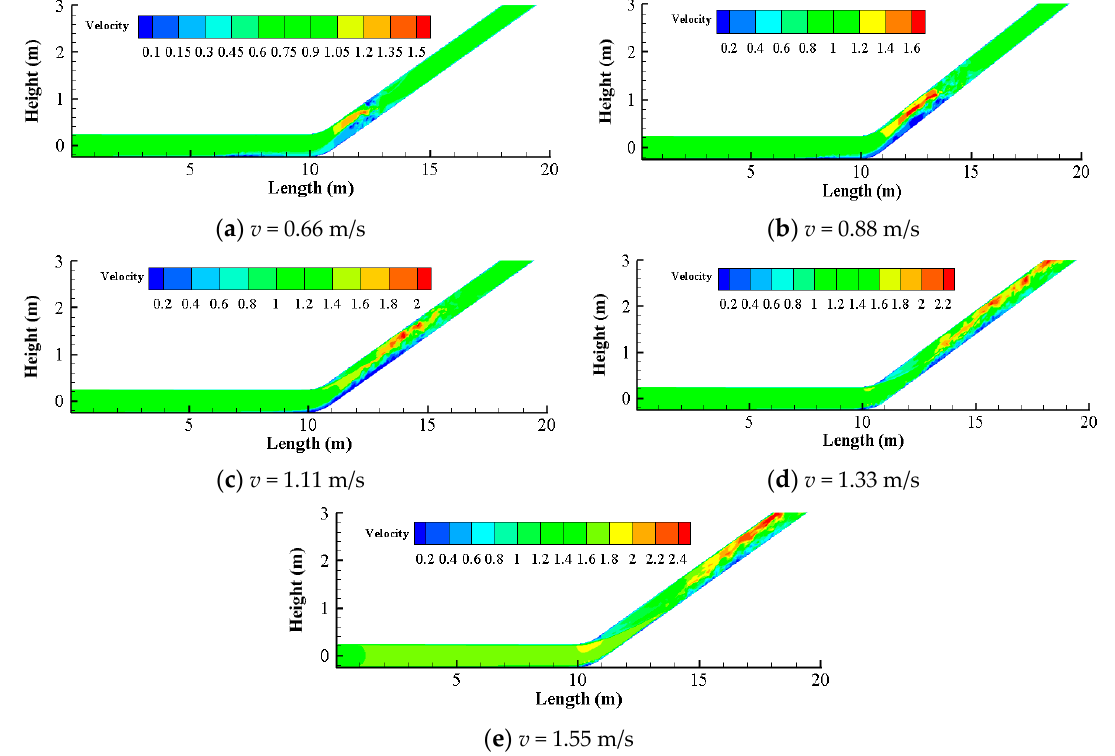
Figure 15. Velocity distribution in pipe at α = 20° ( t = 11.0 s).